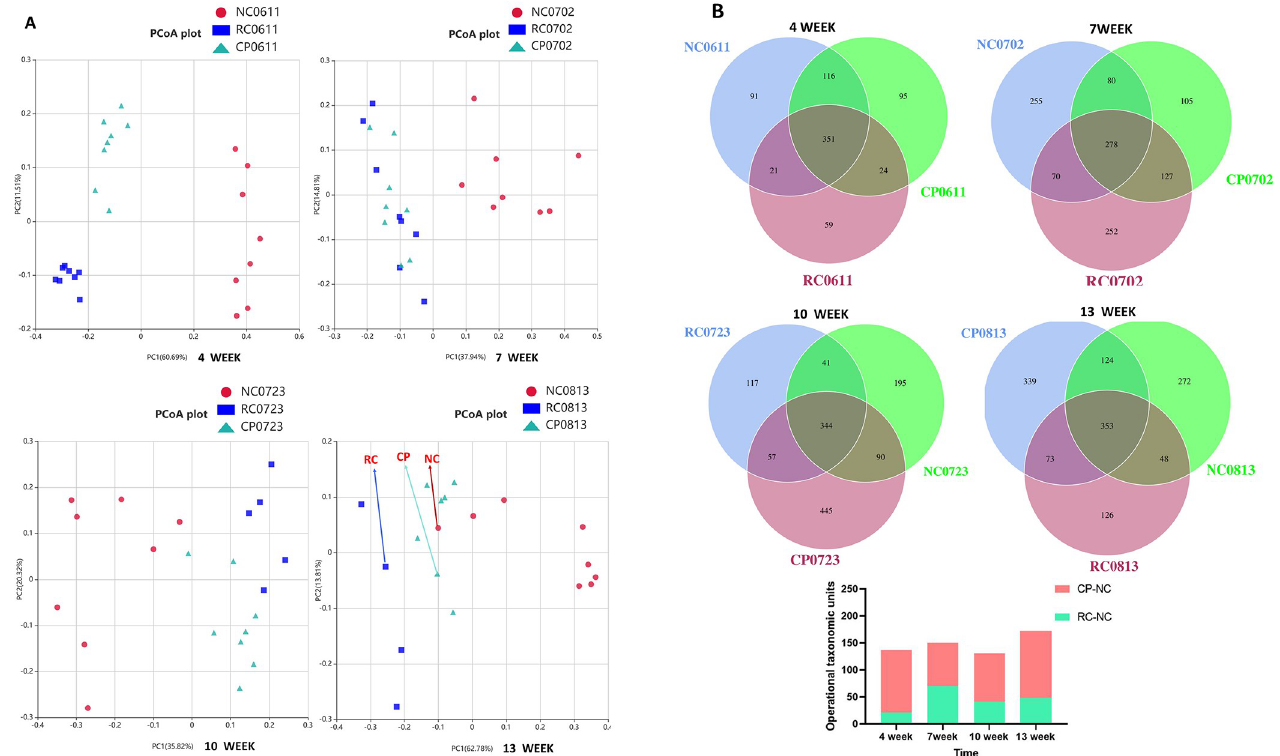
Fig 3. Effect of the probiotic powder on the gut microbiota structure. ( A, B ) PCoA analysis and Venn diagrams of mice at weeks 4, 7, 10, and 13, respectively. PCoA analysis (Principal Co-ordinates Analysis) was used to extract the most important elements and structures from multi-dimensional data by sorting a series of eigenvalues and eigenvectors, and then to select the combination of principal coordinates with the greatest contributions. Closer distances indicate more similarity in species composition. Therefore, samples with highly similar community structures tended to cluster more closely, and samples that differed in community structures showed greater distances. Venn graph was used to analyze the common and unique OTU among different samples (groups) after the OTU results were obtained by clustering Higher numbers of shared OTU indicated greater similarity in community